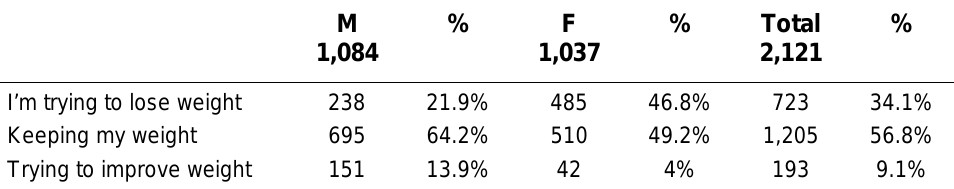
Desire to Lose/Maintain/Increase Weight Among 2,121